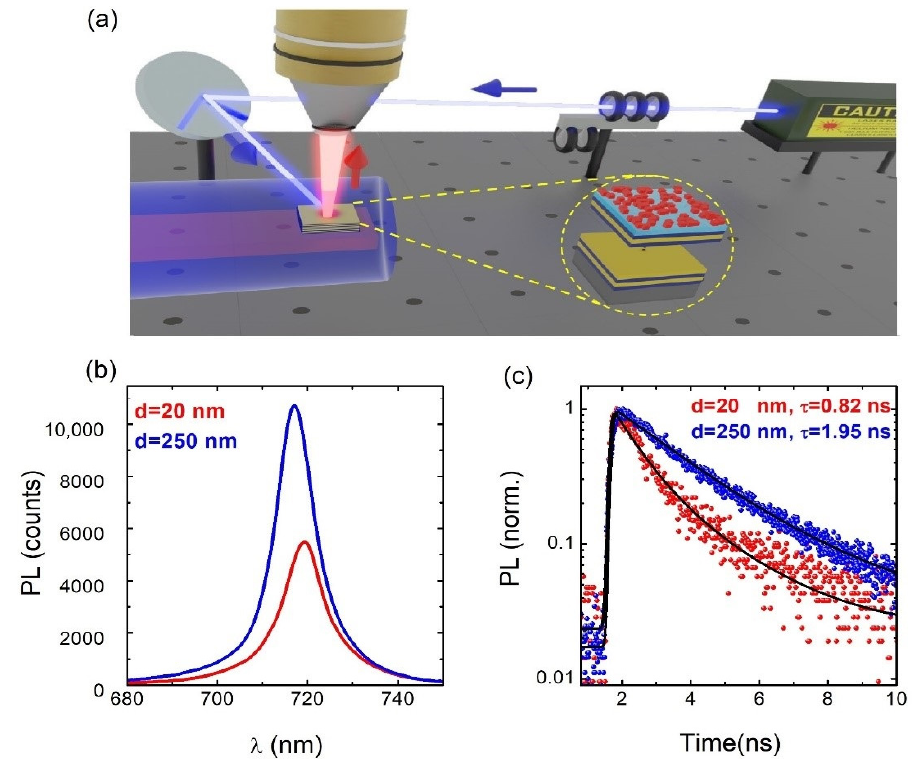
Figure 4. ( a ) Illustration of the experimental setup for measuring the PL and TRPL spectra of PNCs at low temperatures. ( b ) PL spectra of CsPbI 3 PNCs deposited on top of HMM substrates (PNC+HMM) with two different spacer thicknesses, d = 20 nm (red curve) and d = 250 nm (blue curve). ( c ) PL transients of CsPbI 3 PNCs measured at PL peak wavelengths of spectra in ( b ) and two-exponential fittings (black continuous curves). PL and PL transients are measured at 15 K.